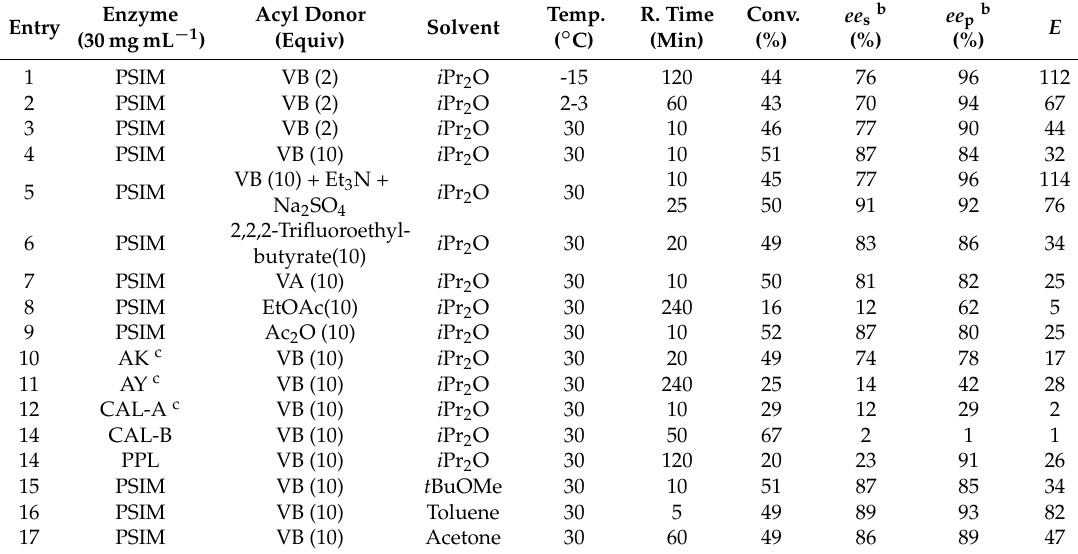
Table 1. Enzyme-catalyzed acylation of ( ± )- 4 a